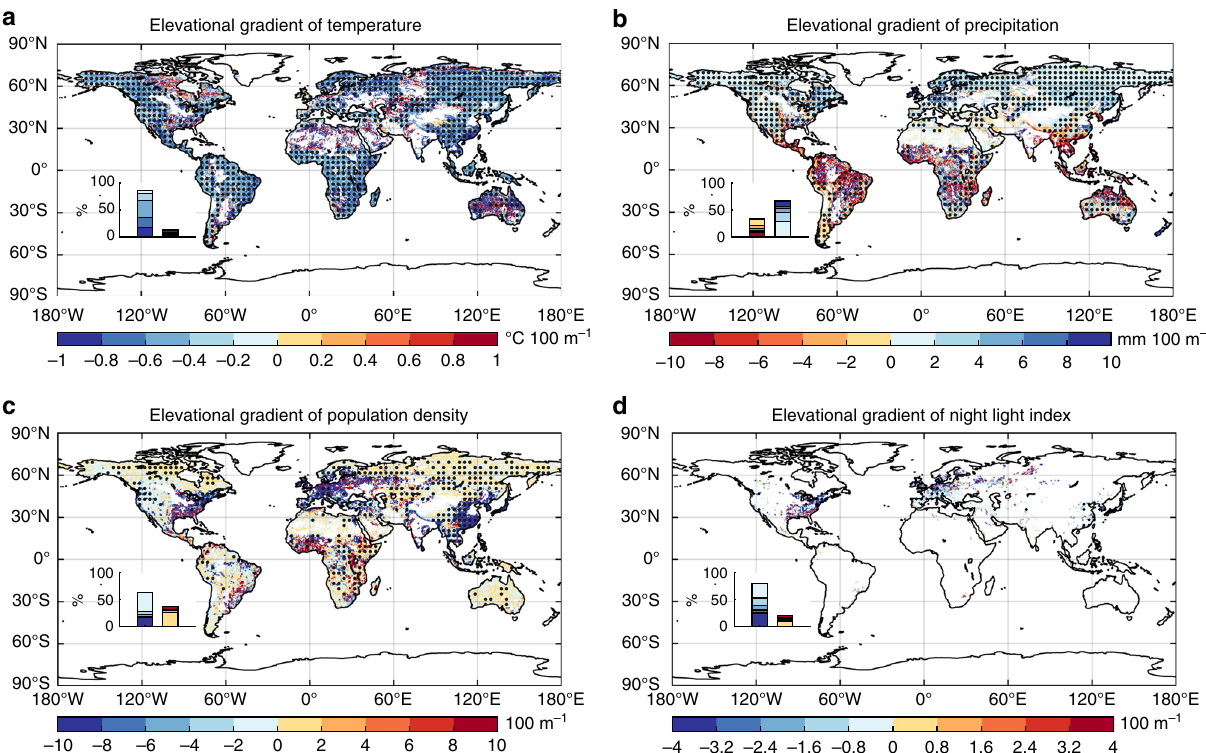
Fig. 2 The elevational gradient (EG) of climate and human activity variables. a The spatial pattern of the EG of mean annual temperature (EG tem ). b The spatial pattern of the EG of total precipitation (EG pre ). c The spatial pattern of the EG of population density (EG pd ). d The spatial pattern of the EG of night light index (EG NLI ). A frequency distribution of the EG values is shown in the inset at the bottom-left for each panel. Regions marked with dots have statistically signi fi cant ( p < 0.05 with the F -test) EG time, the EG sign can be either (A) ampli fi ed or (B) reduced. The combined changes in EG along the elevational gradient and over time are illuminated in Fig. 3. Here (1A) and (2A) indicate increased elevational vegetation dissimilarity; while (1B) and (2B) vegetation homogenization/synchronization.